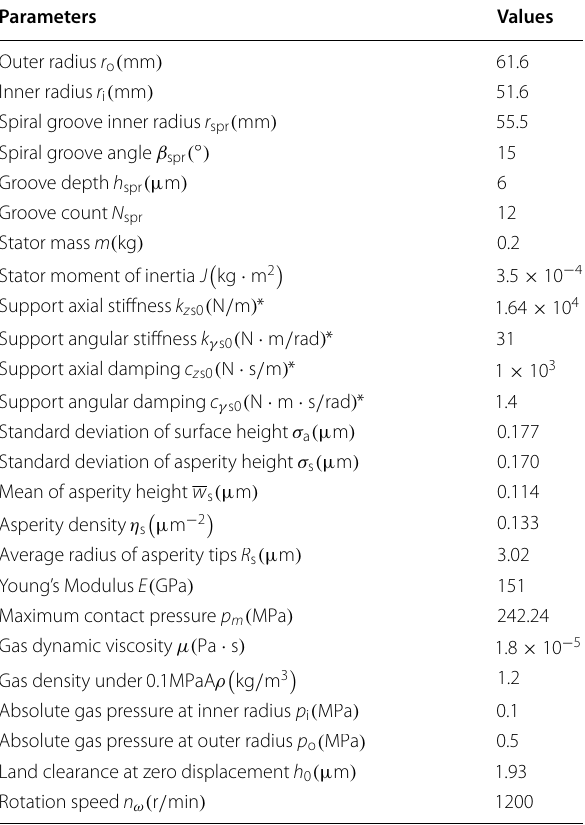
Table 1 Parameters of the gas face seal